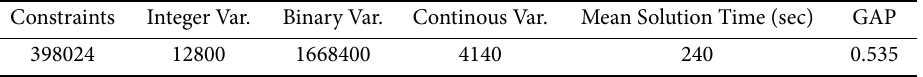
Table 5. Solution characteristics Constraints